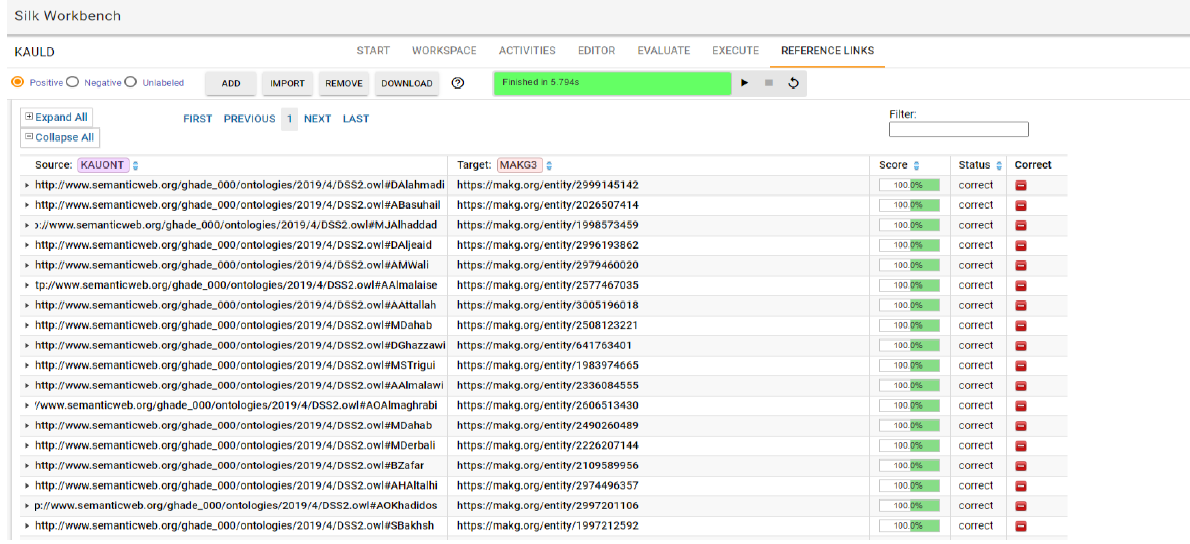
Figure 6. Part of the link results.